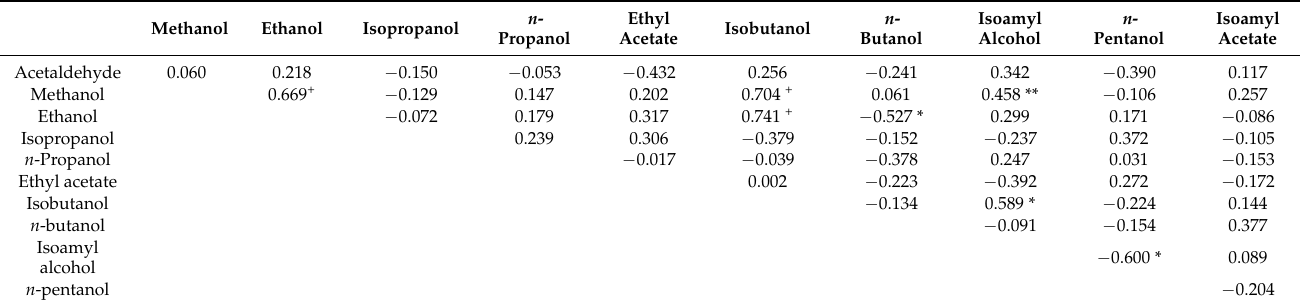
Table 5. Correlation matrix of higher alcohol content in wine samples.